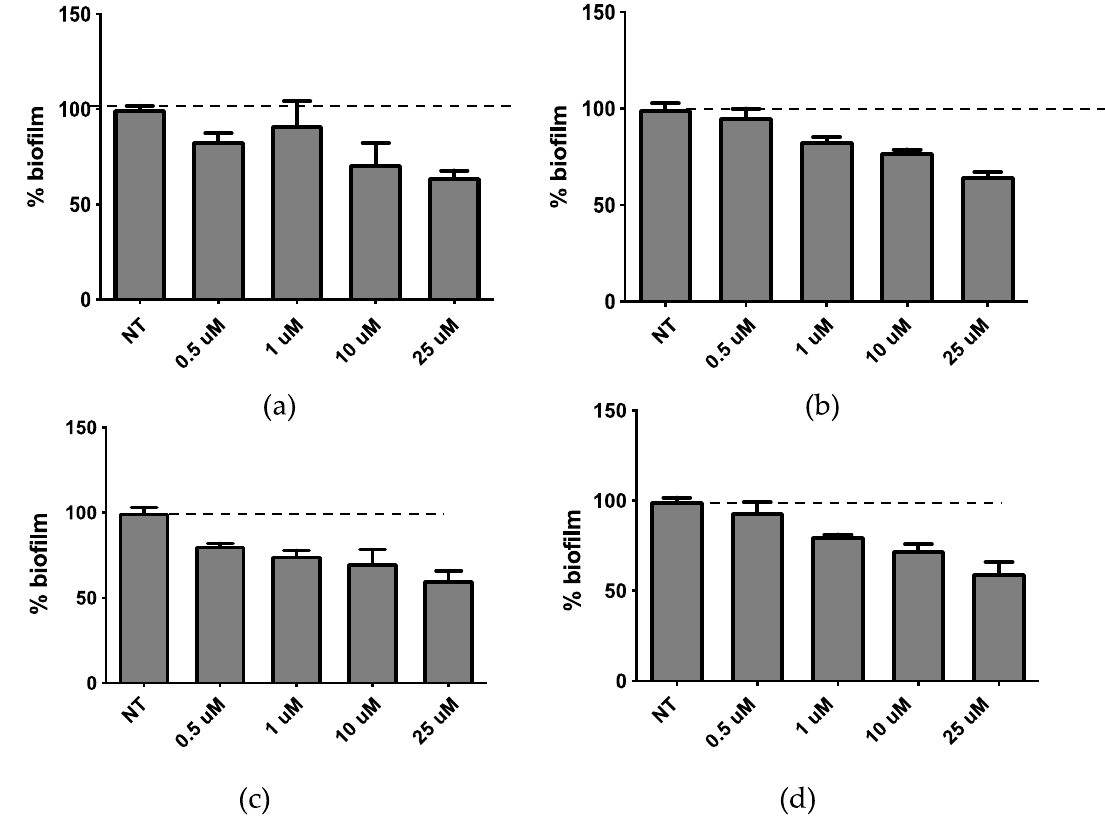
Figure 8. Activity on biofilm of LP-SA loaded CDC ( a , c ) or PF ( b , d ) after 24 h ( a , b ) and 48 h ( c , d ) of treatment.